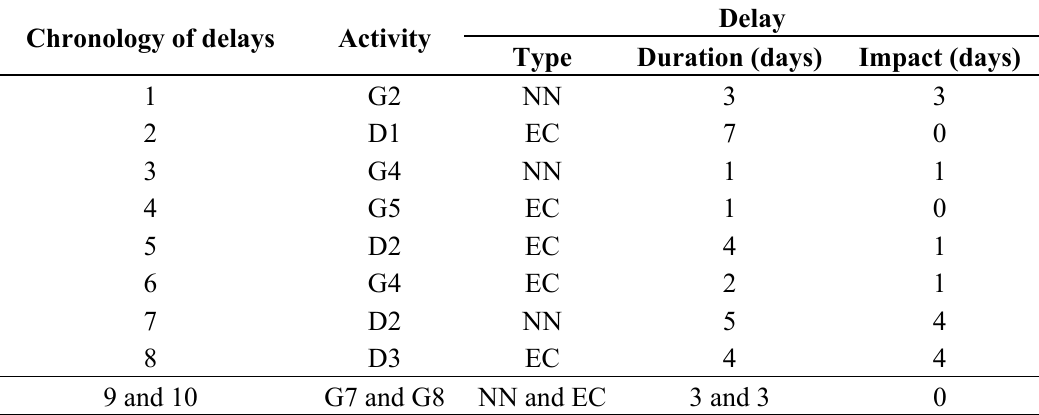
Table 2. Impacted as-planned